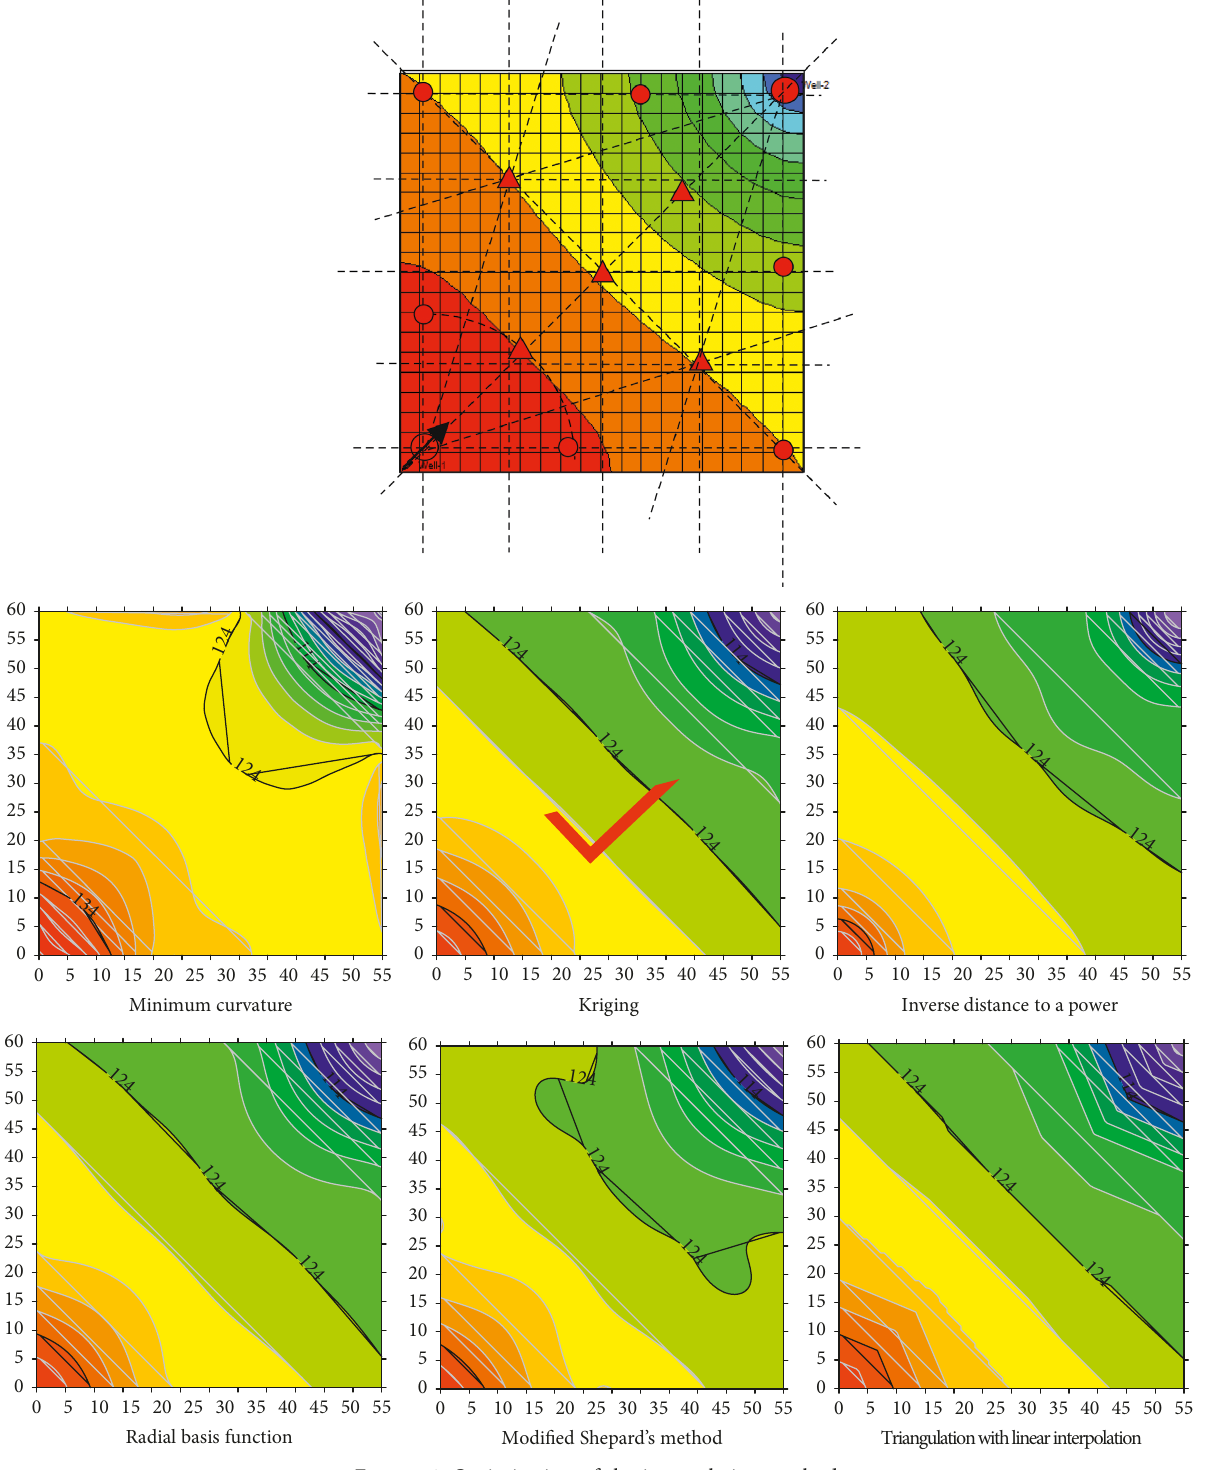
Figure 4: Optimization of the interpolation